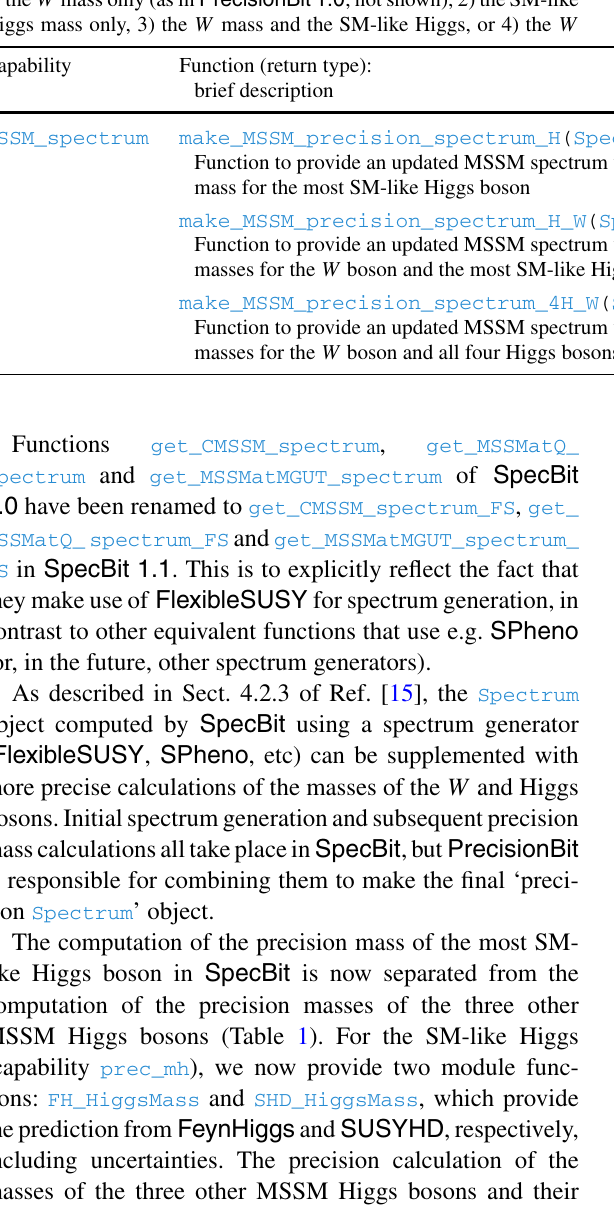
mass and the masses of all four MSSM Higgs bosons. In the latter case, the precision value for the SM-like Higgs mass can be taken from